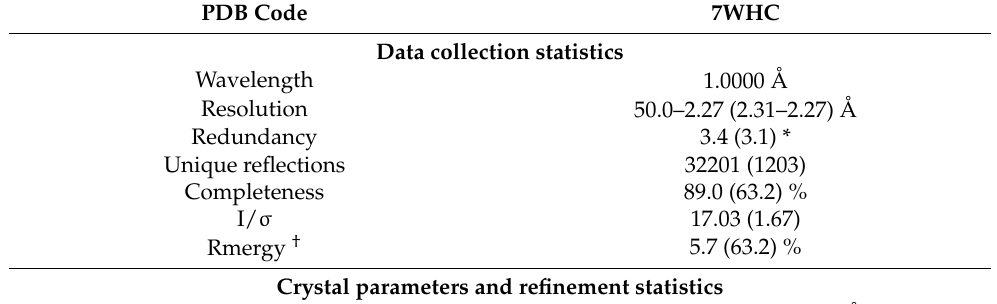
Table 1. Data collection statistics and refinement parameters for the catalytic domain of SARS-CoV-2